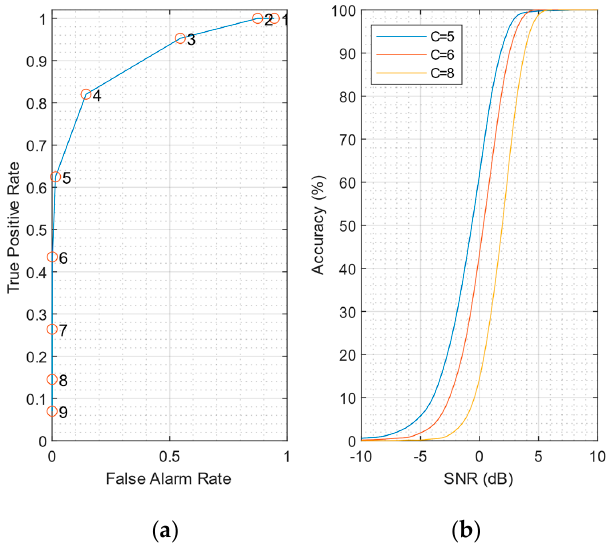
Figure 6. ( a ) ROC curve at SNR = 0 dB, using the mean of the signals coming from the 7 honeycomb pixels. True-positive and false-alarm rates are averaged on 10 datasets. The scale factor C varies from 1 to 9. ( b ) Accuracy curves for different values of scale factor C .